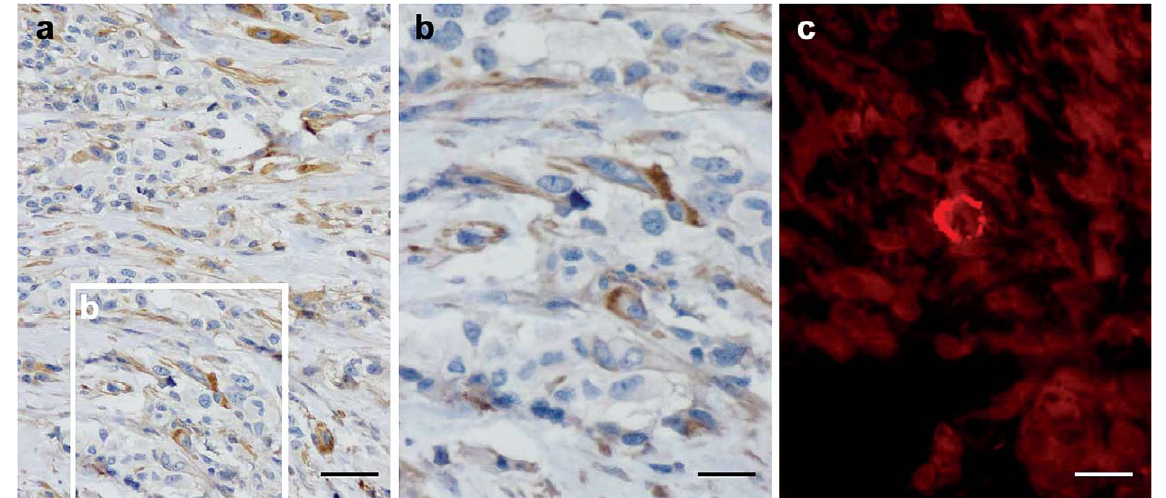
Fig. 1. Immunohistochemical and immunofluorescence analysis of CD133 expression in rhabdomyosarcomas tissues. Both IHC (a, b) and IF (c) revealed membranous CD133 positivity in only small number of tumor cells. Nonspecific cytoplasmic positivity was revealed in a significant proportion of tumor cells (a, b). Immunohistochemistry with Gill’s hematoxylin counterstain (a, b); indirect immunofluorescence using TRITC-labeled secondary antibody (c). Bars, 100 (cid:1) m (a), 50 (cid:1) m (b), 50 (cid:1) m